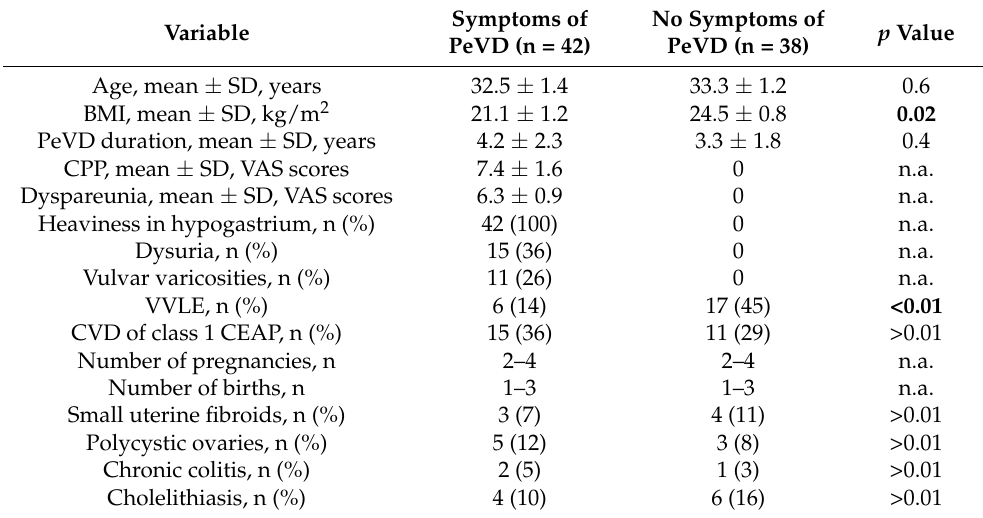
Table 1. Demographic and clinical characteristic of study participants (N =